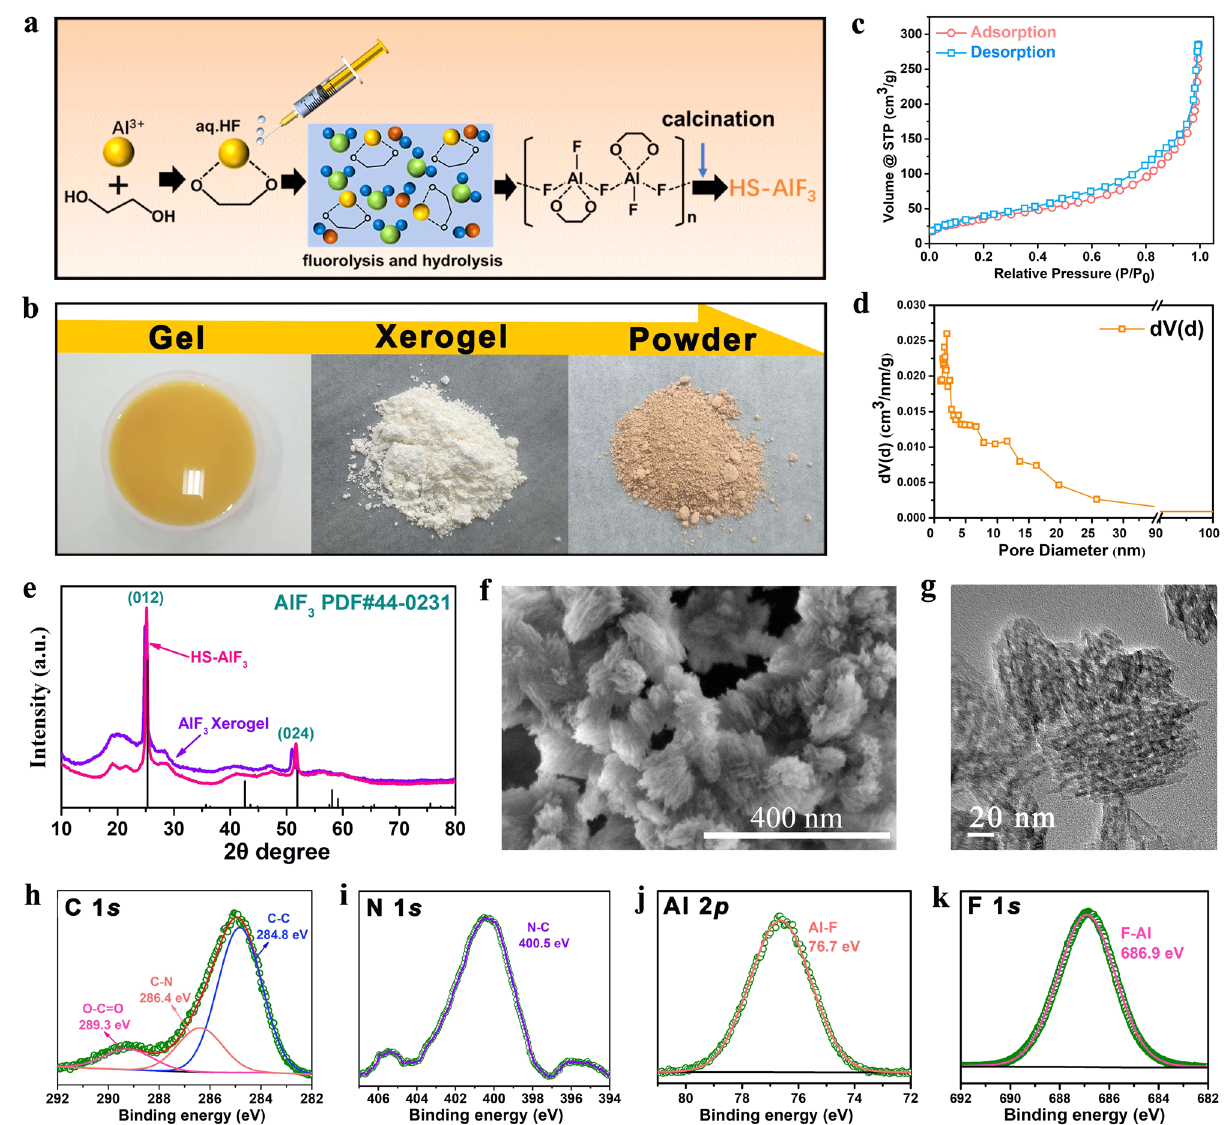
Fig. 2 |Synthesisand characterizationofHS-AlF 3 .a Schematic synthesis process of HS-AlF 3 . b Photos of wet gel, xerogel and fi nal powder in the fl uorolytic sol-gel route for HS-AlF 3 . c Nitrogen sorption isotherms of HS-AlF 3 powder and ( d ) BJH